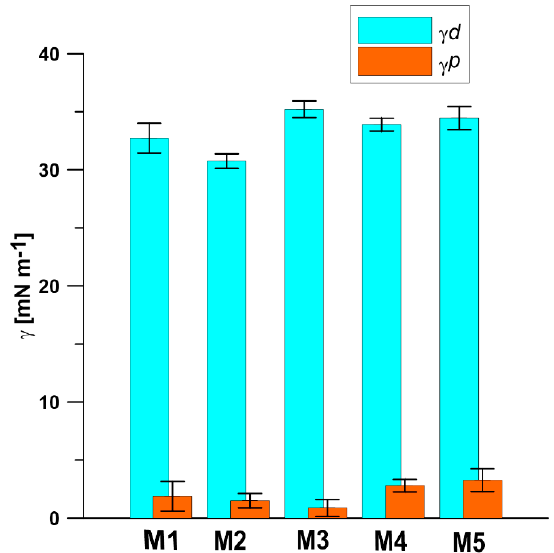
Figure 11. Surface free energy ( γ ) determined for PPSU based membranes surfaces. Superscripts d and p correspond to dispersive and polar components of surface free energy, respectively.